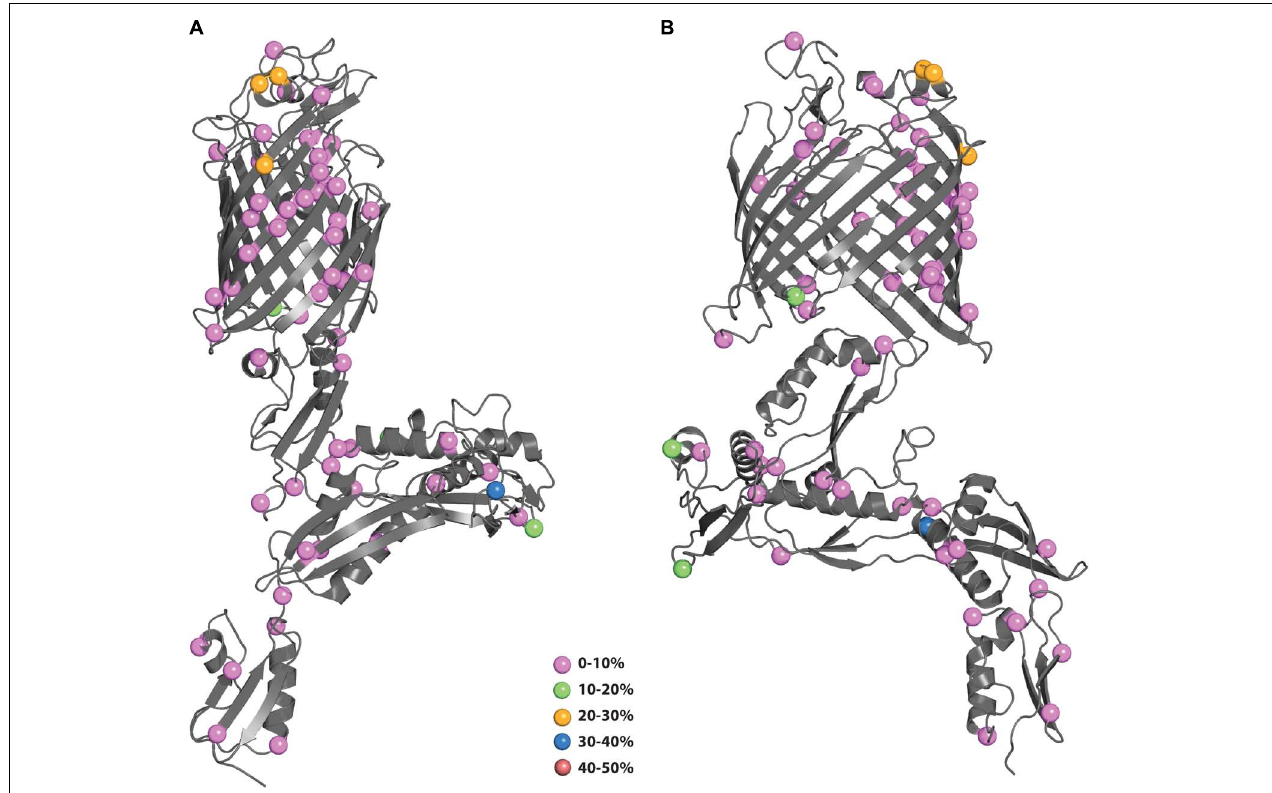
FIGURE 5 | (A,B) Polymorphisms of N. gonorrhoeae BamA mapped onto the crystal structure. The polymorphisms from Figure 4A were mapped onto the structure of BamA (4k3b) and colored according to their prevalence in the population. (B) Shows BamA structure rotated 90 ◦ from (A) .